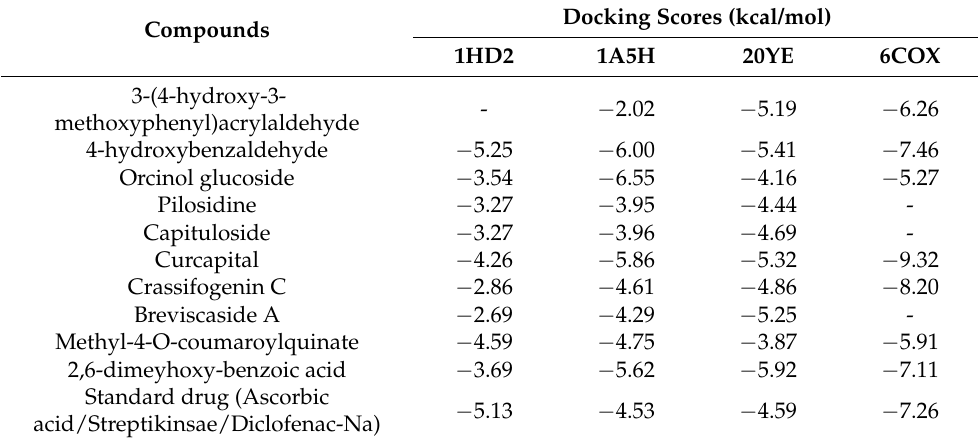
Table 7. Docking scores of the major selected bioactive compounds of M.